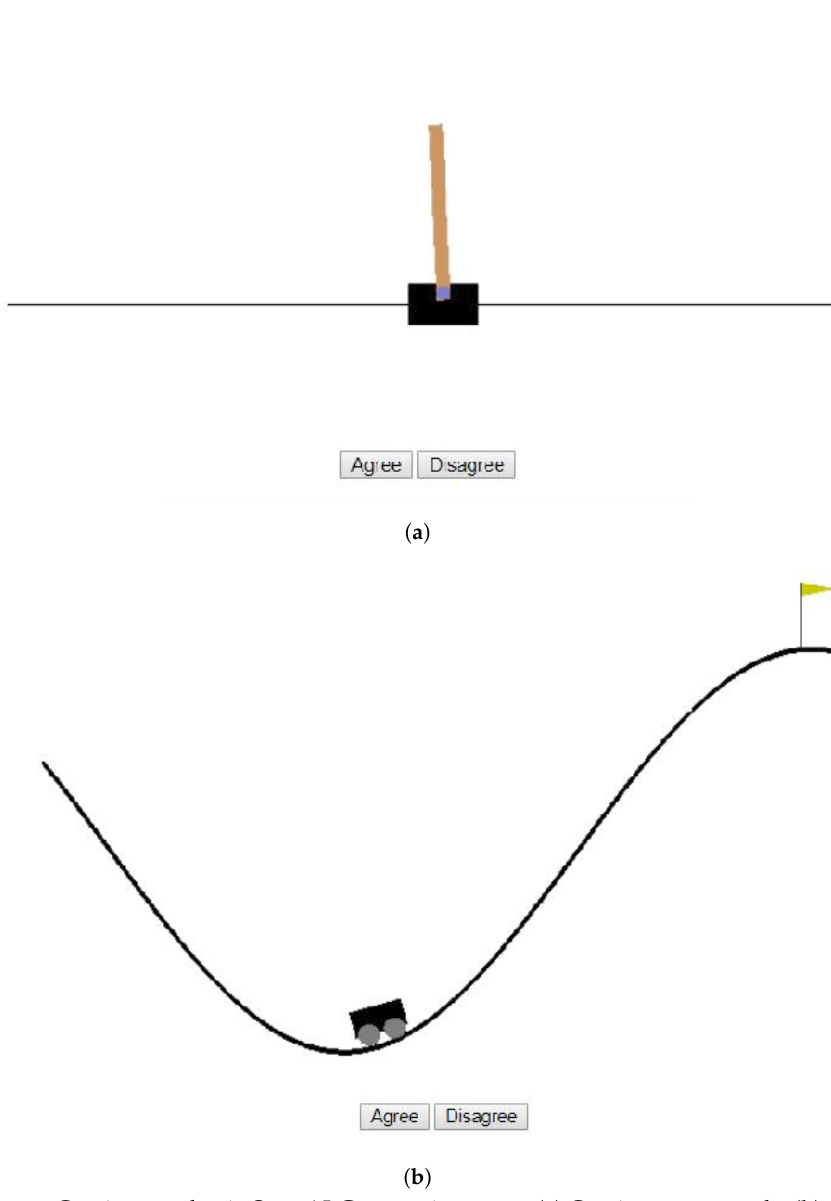
Figure 3. Continuous classic OpenAI-Gym environment: ( a ) Continuous cart-pole; ( b ) continuous mountain-car in the proposed